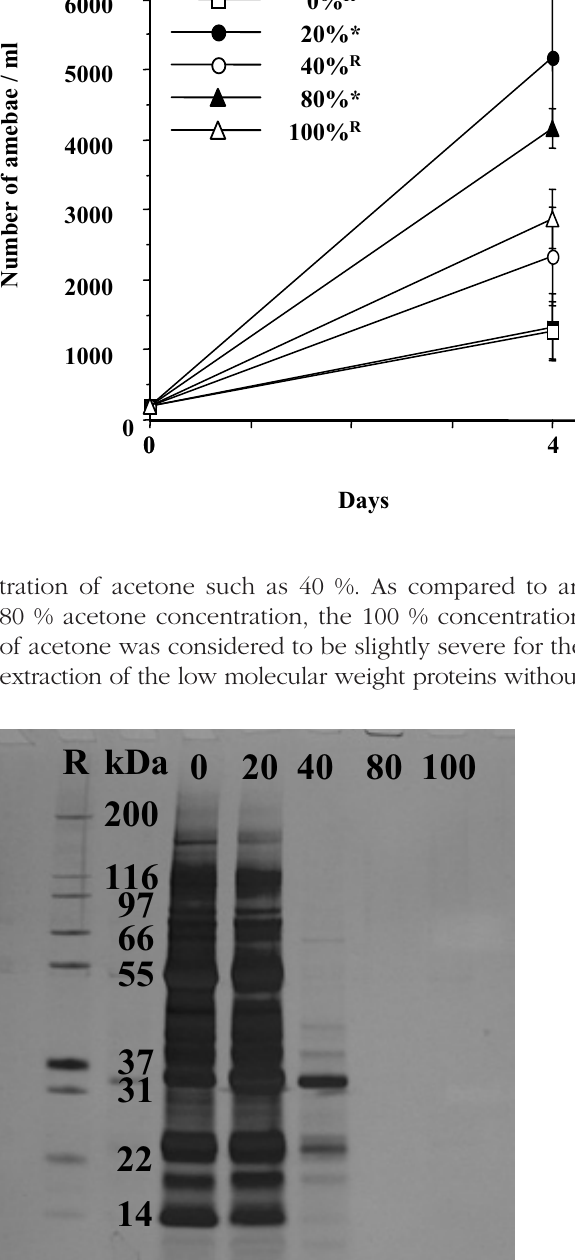
Fig. 2. – Effect of soluble fractions of spiderwort Cp-rich leaf cells extracted with five different concentrations of acetone (0 %, 20 %, 40 %, 80 % and 100 %) on the growth of E. dispar . The growth kinetics of the E. dispar AS 16 IR strain in the YIGADHA-S medium are shown (mean numbers of amoebae in duplicate cultures are plotted). *: the mean of the growth-kinetic level was significantly higher than that of the control (* p < 0.01 by Dunnett’s test). R: the significant difference was retained by Dunnett’s test ( p < 0.05).